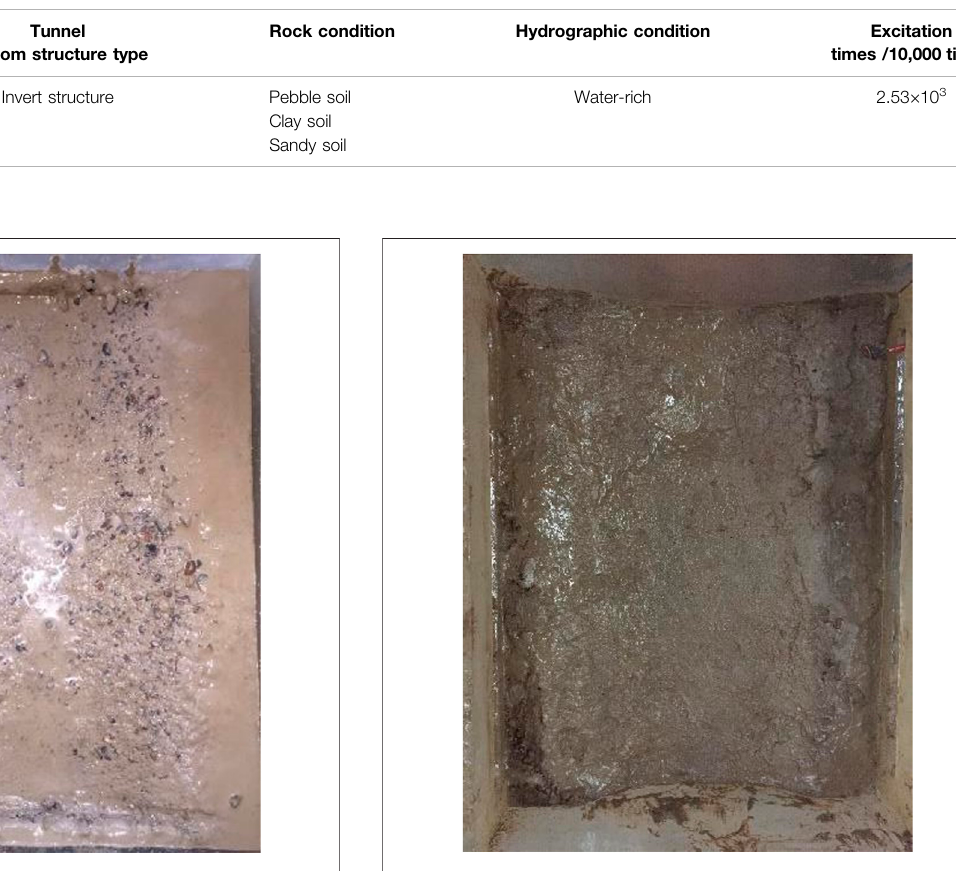
FIGURE 6 | Excitation of water-rich surrounding rock of pebble soil. FIGURE 7 | Excitation of water-rich surrounding rock of clay